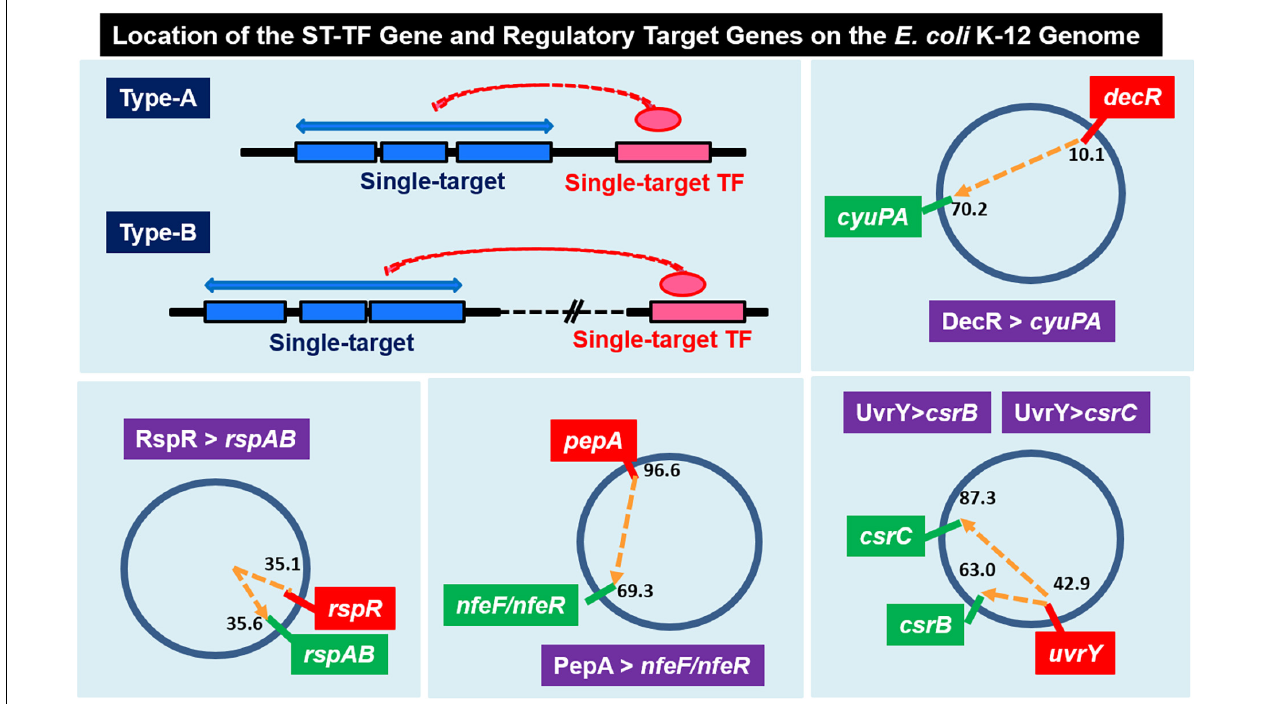
FIGURE 5 | Location of the ST-TF gene and its regulatory target gene on the E. coli K-12 genome. [Type-A] The ST-TF gene is located adjacent to its regulatory target genes. [Type-B] The ST-TF gene is located in a separate position from its target genes. Four type-B gene sets have been identified: decR and its target cyuPA (described in version-1 list) (Shimada et al., 2018b); rspR and its target rspAB ; pepA and its targets nfeA / nfeR genes; uvrY and its targets csrB and csrC genes (all described in this report). The number indicates the position of the gene on the E. coli K-12 genome as centisome.